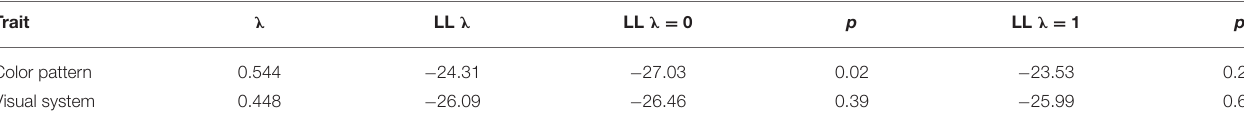
TABLE 4 | Estimates of phylogenetic signal ( λ ) between simplified color pattern (e.g., stripes vs. bars) and visual system (e.g., UV and non-UV).